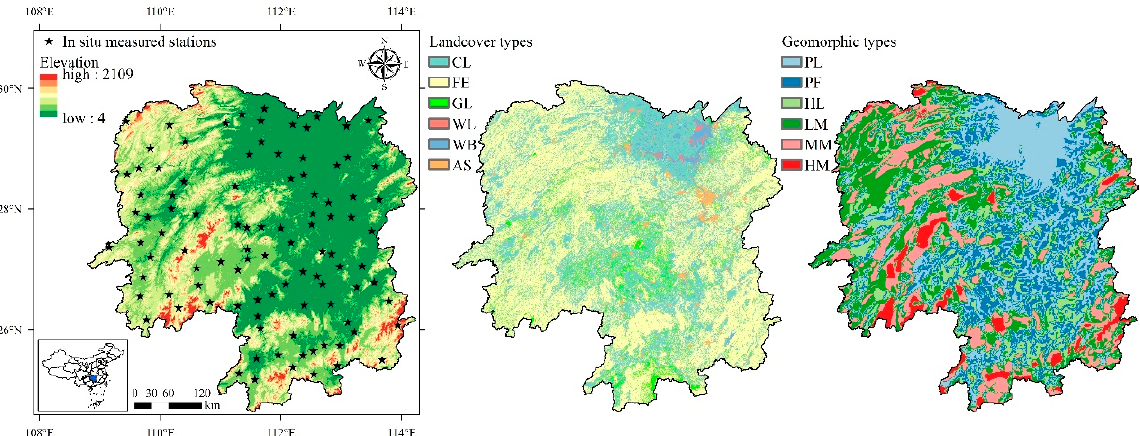
Figure 1. Topographical map showing the distribution of in situ measurement stations, land cover and landforms in Hunan Province; abbreviations for land cover are: CL Cultivated land, FE Forest, GL Grassland, WL Wetland, WB Water body, AS Artificial surfaces; abbreviations for landform are: PL Plain, PF Platform, HL Hill, LM Low relief mountain, MM Medium relief mountain, HM High relief mountain.